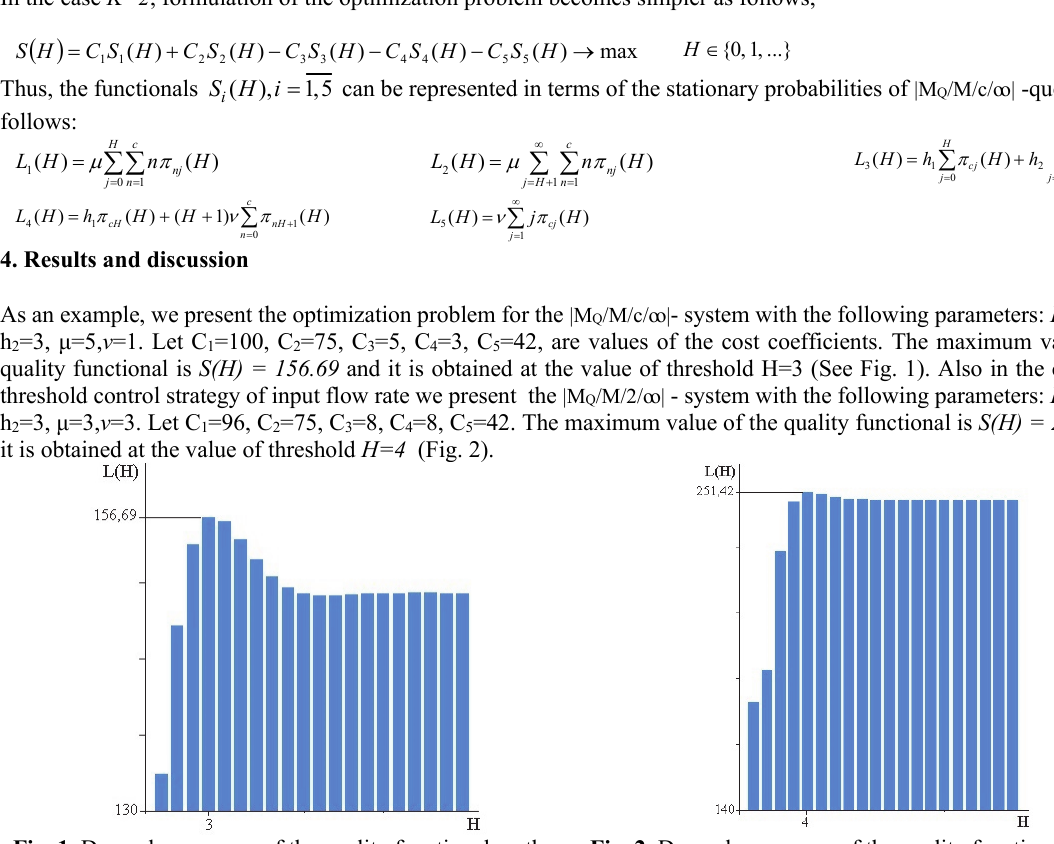
Fig. 1. Dependency curve of the quality functional on the control strategy for the |M Q /M/1/ ꝏ | - system